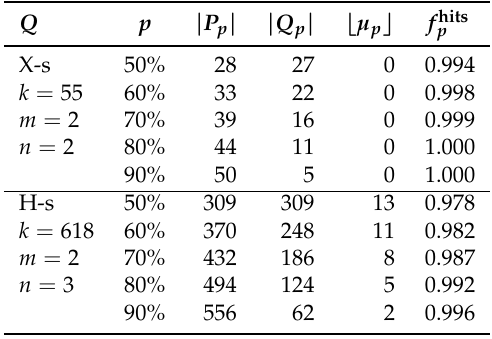
Figure 3. Data set “X-shape” has 55 points, 2 features (coordinates x , y ), and 2 classes. Class c 1 has 28 points (olive green dots) and class c 2 has 27 points (red dots). Table 1. Similarity valuation LBNN classification performance for the “X-shaped” (X-s) and “hemisphere-sphere” (H-s)